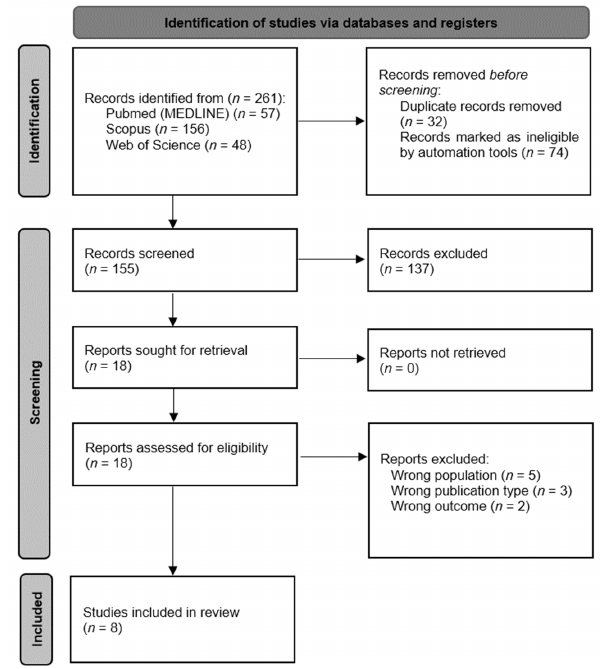
Figure 1. Flow diagram of the study selection process.